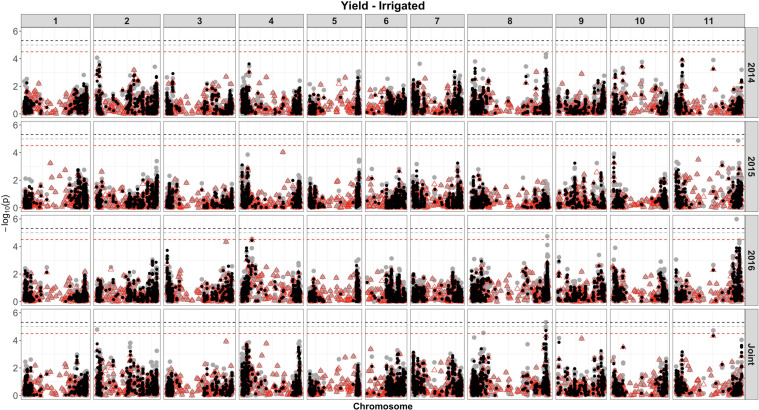
Manhattan plot of the associations for GY, under irrigation, using a single-based GWAS (gray circle), segment-based GWAS (red triangle), and gene-based GWAS (black circle) based on the role set of experimental data. Gray, red, and black lines indicate Bonferroni-corrected threshold with an experimental type I error rate at α = 0.05.